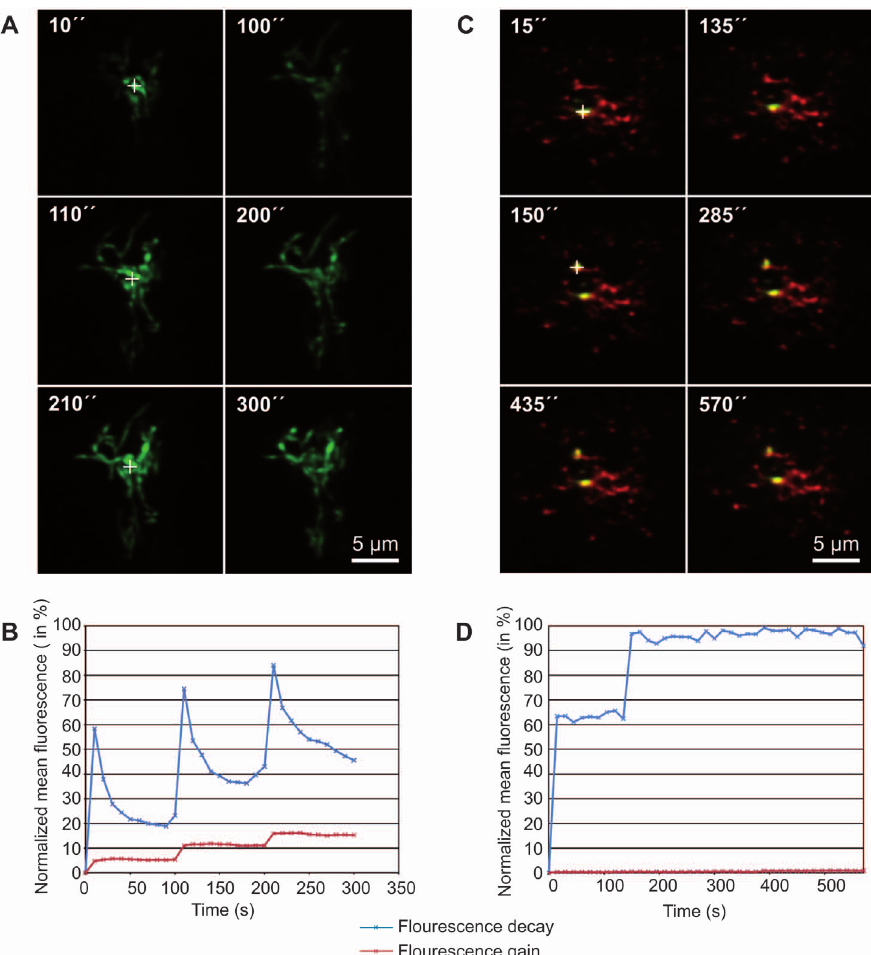
Figure 3 Peroxisomal matrix proteins are kept back during peroxisome elongation. HEK293T cells expressing either the mitochondrial matrix marker, paGFP-mito (A, B), or the peroxisomal matrix marker, paGFP-Px and mRFP- Hs PEX11 g (C, D) were analyzed 48 h after transfection. Diffusion of matrix proteins was analyzed in repetitive fluorescence decay after photoactivation (rFDAP) experiments. paGFP was activated in a small area and fluorescence was monitored for decay along with measurement of fluorescence gain in the rest of the cell. (A) For mitochondria, repetitive activation of a single area (white crosses) led to rapid diffusion of the paGFP signal throughout the mitochondrial network. (B) Quantification of (A) showing fluorescence decay in the activated region (blue line) and gain of fluorescence in the non-activated region (red line). (C) paGFP was activated in JEPs caused by overexpression of mRFP- Hs PEX11 g . Since no decay was measured in the activated region (white cross 15 0 ), a second area was activated (white cross 150 0 ). (D) Quantification clearly shows that no signal was lost during acquisition and no diffusion took place. Image acquisition parameters: LSM DuoScan (ApoChromat 63x1.4; settings: paGFP (489 nm, MBS490, BP 500–525), mRFP (532 nm, MBS 535,